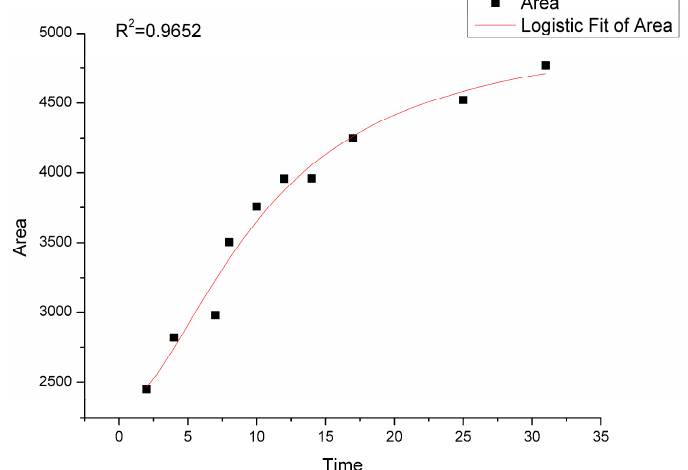
Figure 10. The graph of logistic fitting of the canopy area in the sakura region from 2 April to 1 May 2019. Table 4. The summary of the results of logistic fitting of the sakura region.